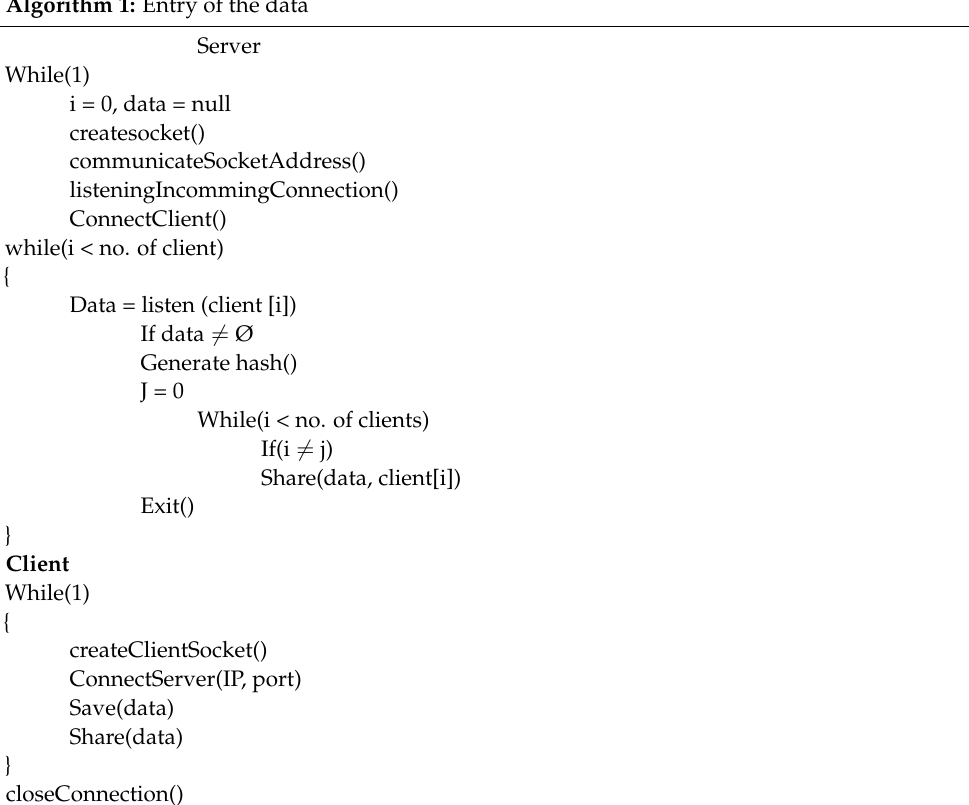
Algorithm 1: Entry of the